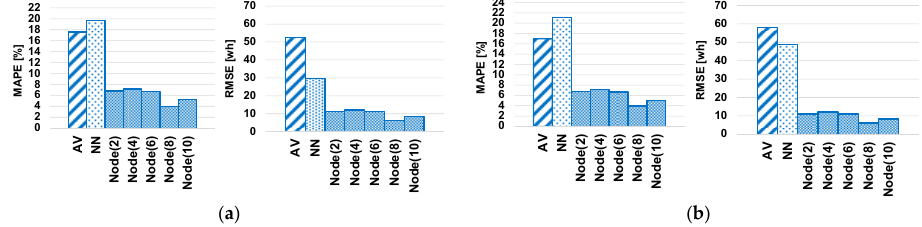
Figure 8. MAPE and RMSE of the estimation result for each estimation method, where AV and NN denote the average and NN-based methods, respectively: ( a ) Load without outliers, ( b ) Load with outliers. Table 1. Comparison of accuracy for the estimation of missing smart meter readings.